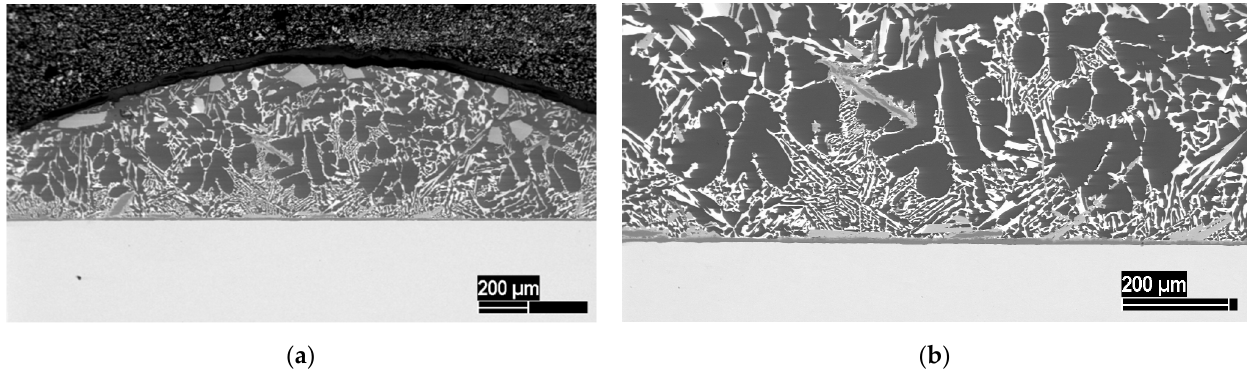
Figure 5. Microstructure of AISI 304 wetted with Al ‐ 40.0Ge ‐ 3.4Si wt.% filler alloy according to 540 °C/10 min mode, obtained by SEM at various magnifications: ( a ) 50× magnification; ( b ) 100× magnification.